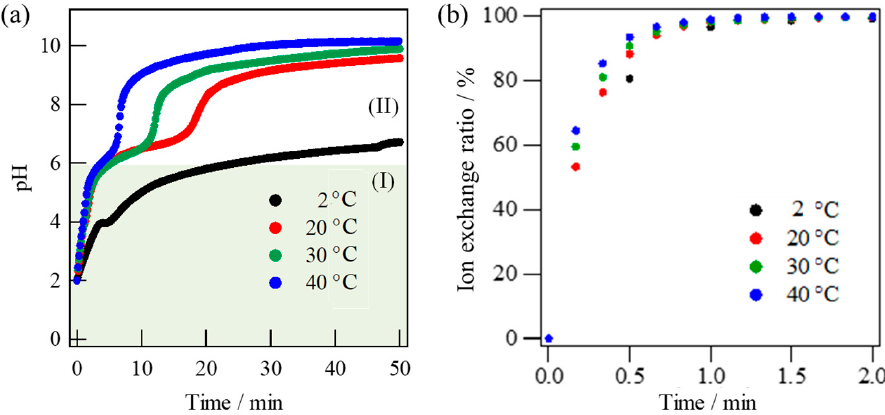
Figure 5. Time-changes of pH values ( a ) and Na + exchanged rates ( b ) during ion exchange of Narpsio glass-ceramic powders at various temperatures.